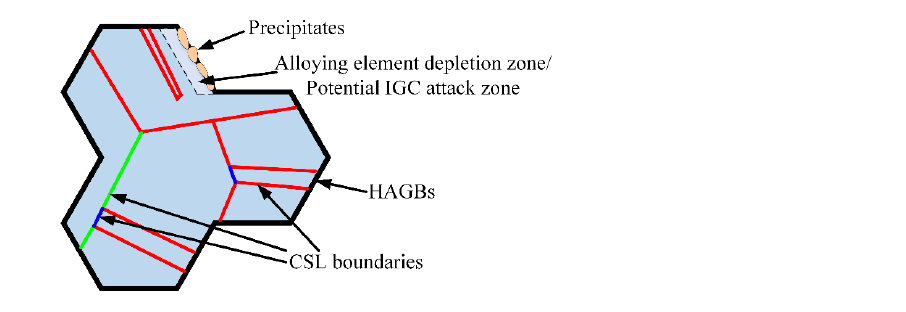
Figure 10. Schematic of the sensitized precipitation and its influence on IGC for C276 superalloy. Based on the above analysis, it can be seen that the GBCD affected the sensitization and IGC of C276 superalloy dramatically. The GBCD can be optimized through cold rolling and annealing processes. By GBE processing, the resistances to sensitization and IGC attack can be improved. Therefore, aiming at improving the performance of C276 superalloy, it is recommended to promote the CSL fraction and grain size through GBE